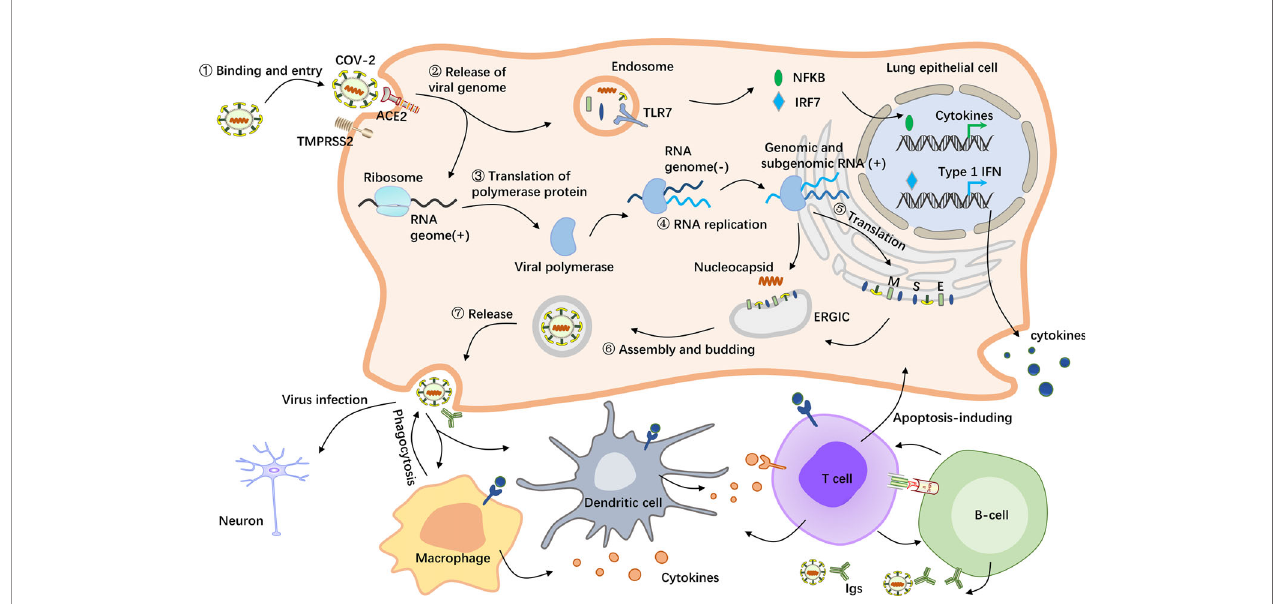
FIGURE 1 | Schematic representation of the pathological mechanism of COVID-19. SARS-CoV-2 enters host cells by fi rst binding to angiotensin-converting enzyme 2 (ACE2) via the surface spike (S) protein. Furthermore, effective host cell entry depends on cleavage of the S1/S2 site by the surface transmembrane protease serine 2 (TMPRSS2) (26, 27). Following entry of the virus into the host cell, viral genomic RNA is released into the cytosol, where it is translated into viral polymerase proteins. Here, subgenomic ( – ) RNAs are synthesized and used as templates for subgenomic (+) messenger RNAs (mRNAs). The nucleocapsid (N) structural protein and viral RNA are replicated, transcribed, and synthesized in the cytoplasm, whereas other viral structural proteins, including the S protein, membrane (M) protein and envelope (E) protein, are transcribed and then translated in the endoplasmic reticulum (ER). The resulting structural proteins are inserted into the ER-Golgi intermediate compartment (ERGIC) for virion assembly, followed by release of the nascent virion from the host cell via exocytosis. Subsequently, the resulting massive number of virus particles fi rst activate innate immune cells such as macrophages and dendritic cells, which can not only kill the infected cells but also control the viral replication in the cells by secreting cytokines and activating more immune cells to reach the infected site (28). In this process, B cells produce and secrete numerous antibodies that bind to the virus, thereby blocking the virus from entering the body and enhancing viral phagocytosis by phagocytes. In addition, the nucleic acid substance RNA released from the virus will be recognized by the pattern recognition receptor TLR7, which is located on the endosomal membrane surface and can recognize RNA (29). After activation of TLR7 by viral RNA, multiple proteins are recruited to form a complex, which promotes the transfer of transcription factors such as NF-kB and IRF7 to the nucleus and activates the expression of proin fl ammatory cytokines, which regulate viral clearance by the host immune system (30,